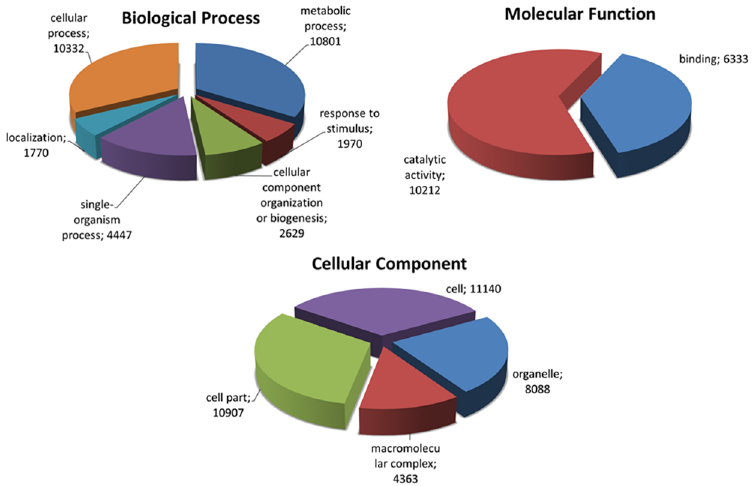
Fig 3. Annotated gene ontology (GO) term distribution at 2-level for the three GO categories after GO-slim analysis.